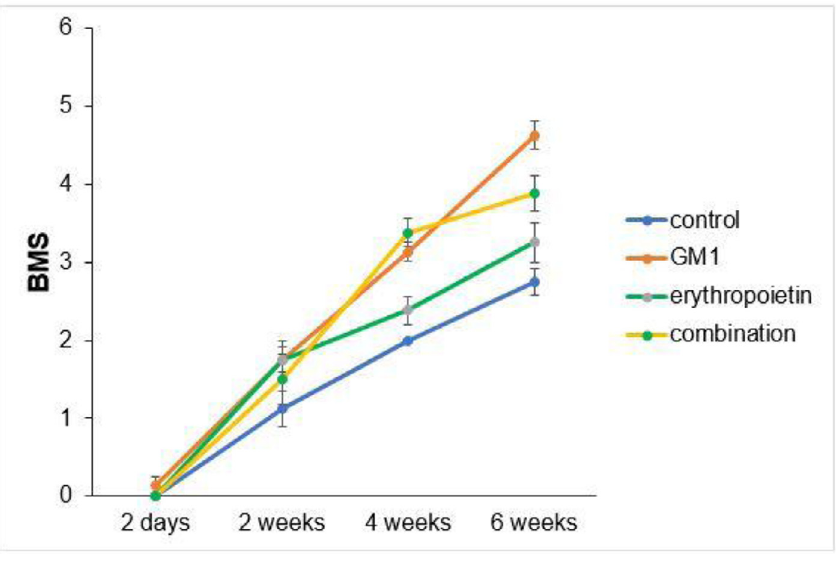
Fig. 1. BMS scale mean pro fi les per group and respec- tive standard errors.